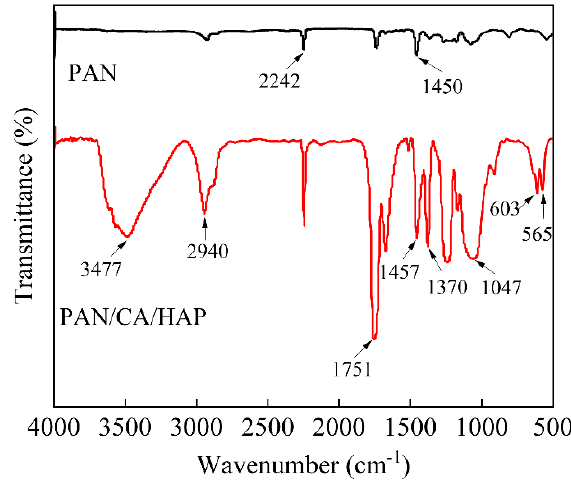
Figure 1. FT–IR spectra of pure PAN separator and PAN/CA/HAP composite separator.